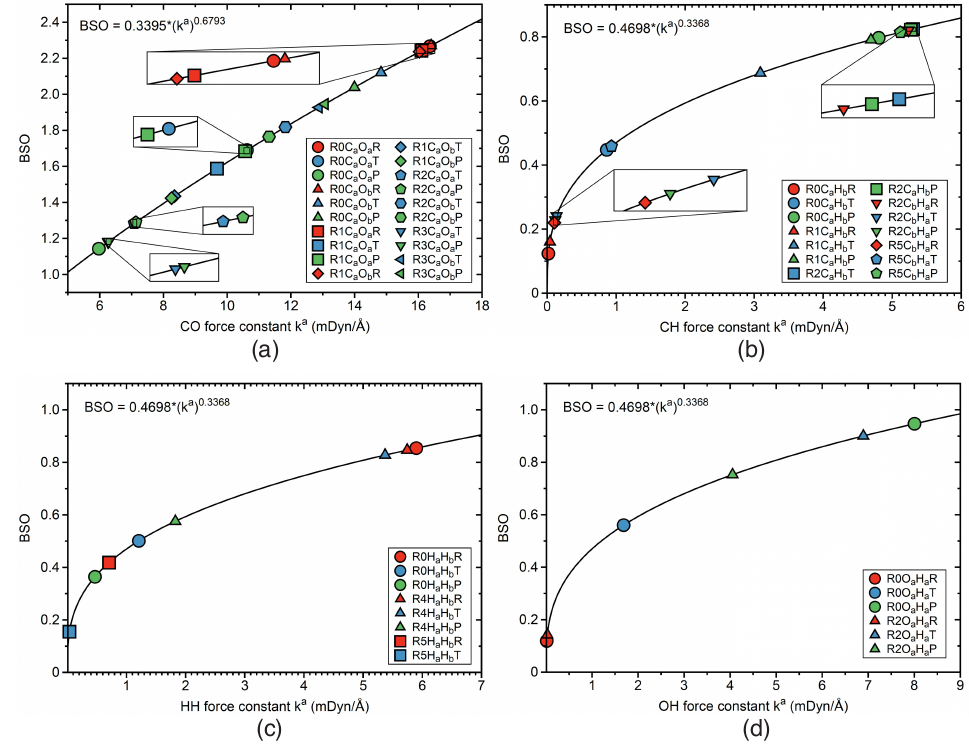
Figure 10. BSO values as a function of the local mode force constants k a , calculated from the power relationship BSO = A ∗ ( k a ) B ; for details, see text and Table 1. ( a ) CO bonds; ( b ) CH bonds; ( c ) HH bonds; ( d ) OH bonds. Labels R0C a O a R, R0C a O a T, and R0C a O a P indicate reactant RE (red color), TS (blue color), and product PR (green color) of the bond involving the C a and O a atoms of reaction R0 . Similarly notation for the reactions R1 – R5 . For the bond label description see the text. B3LYP/6- 31G(d,p)/SDD(Ir) level of theory.